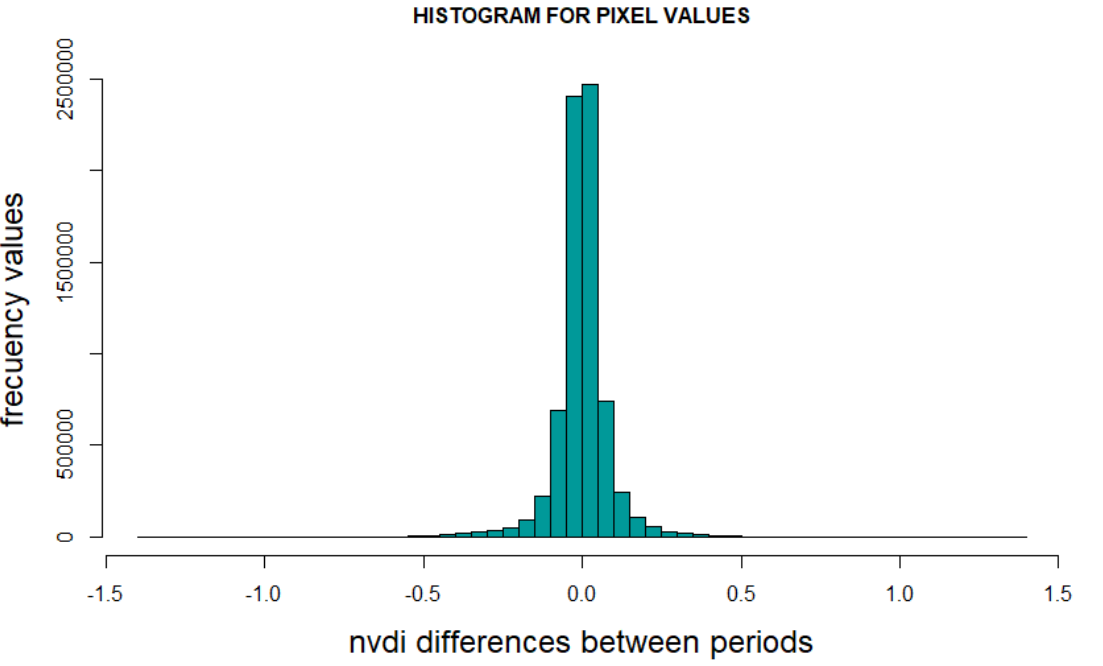
Figure 3. Frequency distribution of the 197,398 values with their trends for the 53 periods analyzed. The locations of the pixels that met the threshold conditions defined in each period were related to the surfaces. A database was obtained, including the period, identification of the plot and fall surface and its percentage in relation to the surface of each plot. This information was compared with RGB images. A total of 135 plots were selected and statistically analyzed). When felling is detected, statistical analyses are carried out for pixels below − 0.12: mean of the values, twenty-fifth percentile, fiftieth percentile, seventy-